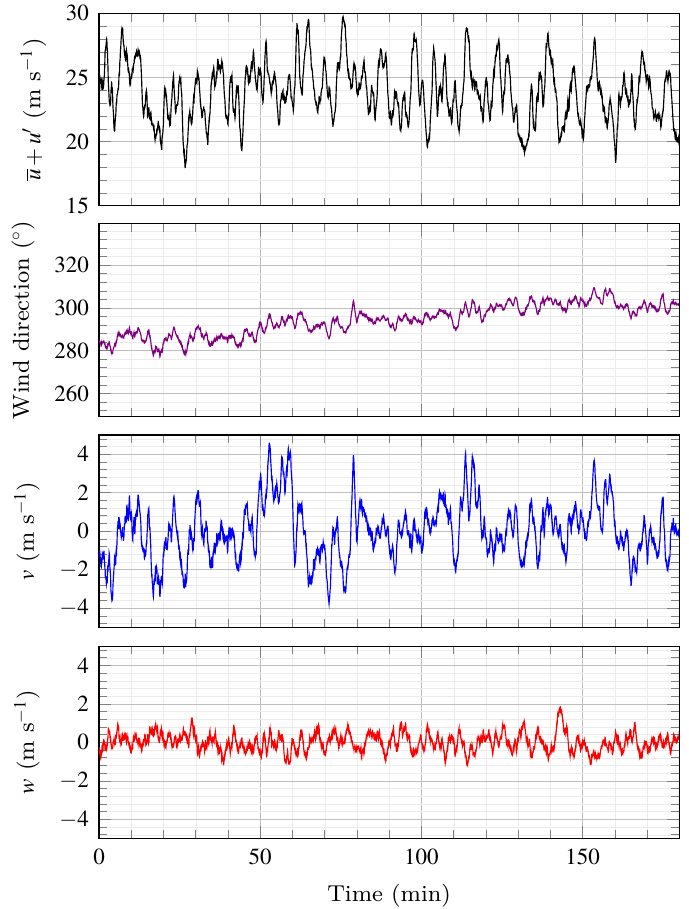
Figure 3. One-minute moving average time series corresponding to storm Aina (December 2017) from 2:00 a.m. to 5:00 a.m. on 8 December 2017 using one of two anemometers mounted 49m above ground on